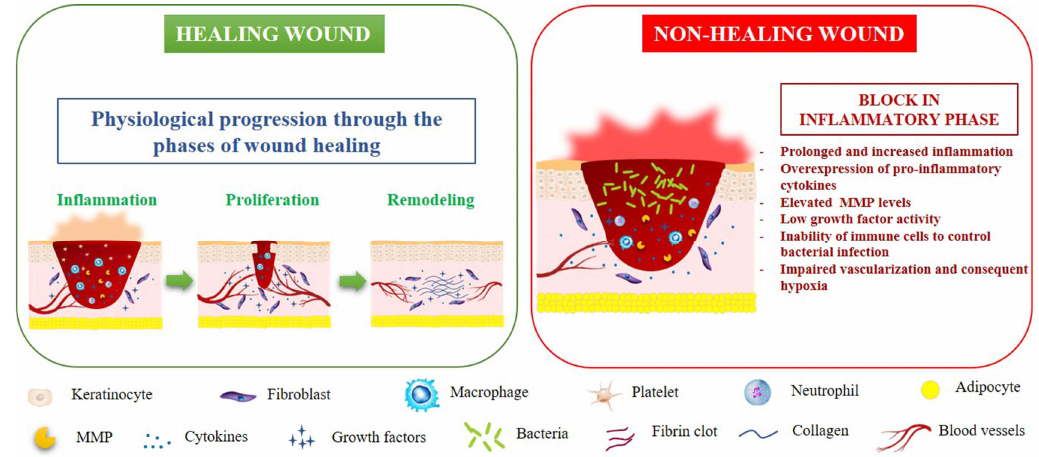
Figure 1. The pathophysiology of healing and non-healing wounds. MMP: matrix